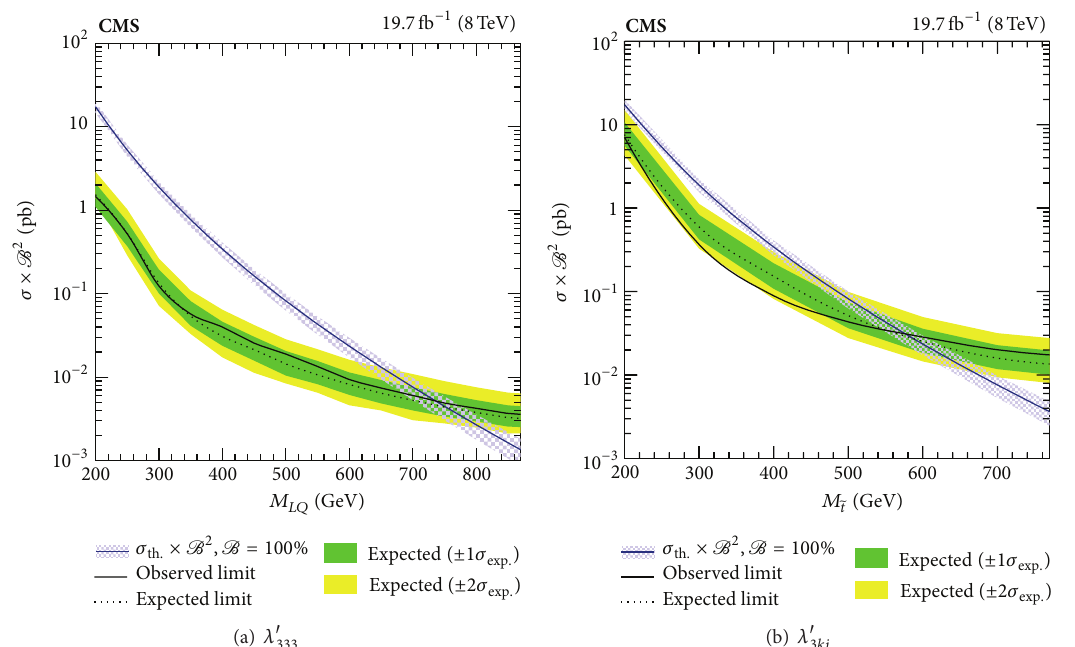
Figure 8: The expected (observed) combined upper limits on the third-generation LQ pair production cross section 𝜎 times the square of the branching fraction, B 2 . These limits also apply to top squarks decaying directly via the coupling 𝜆 󸀠 333 (a). The limits (b) apply to top squarks with a chargino-mediated decay through the coupling 𝜆 󸀠 3 𝑘𝑗 (from [42]).